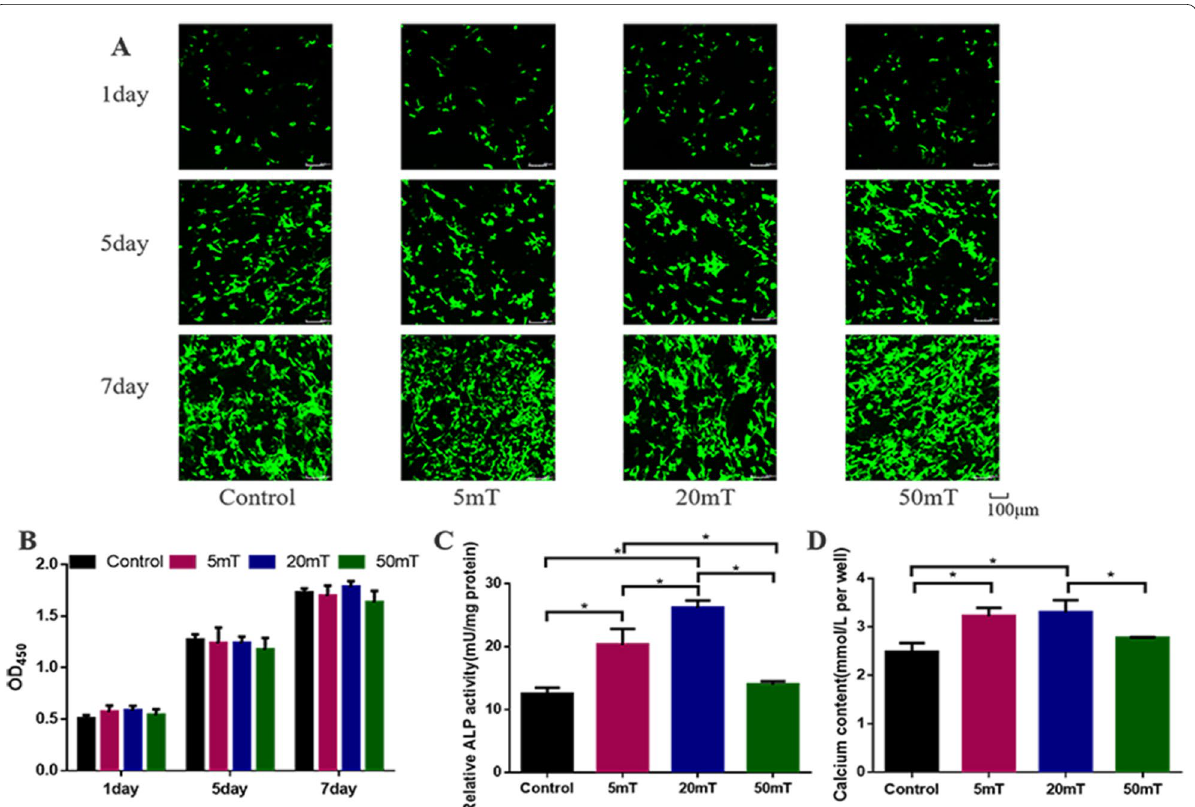
Fig. 7 Effect of magnetic fields on HUMSCs proliferation and osteogenic differentiation A The live/dead staining of HUMSCs after seeding on the S1 scaffolds for 1, 5, and 7 days. B The HUMSCs proliferation after seeding on the S1 scaffolds for 1, 5, and 7 days. C Quantitative analysis of ALP activity in HUMSCs cultured for 7 days. D Calcium contents in HUMSCs cultured for 14